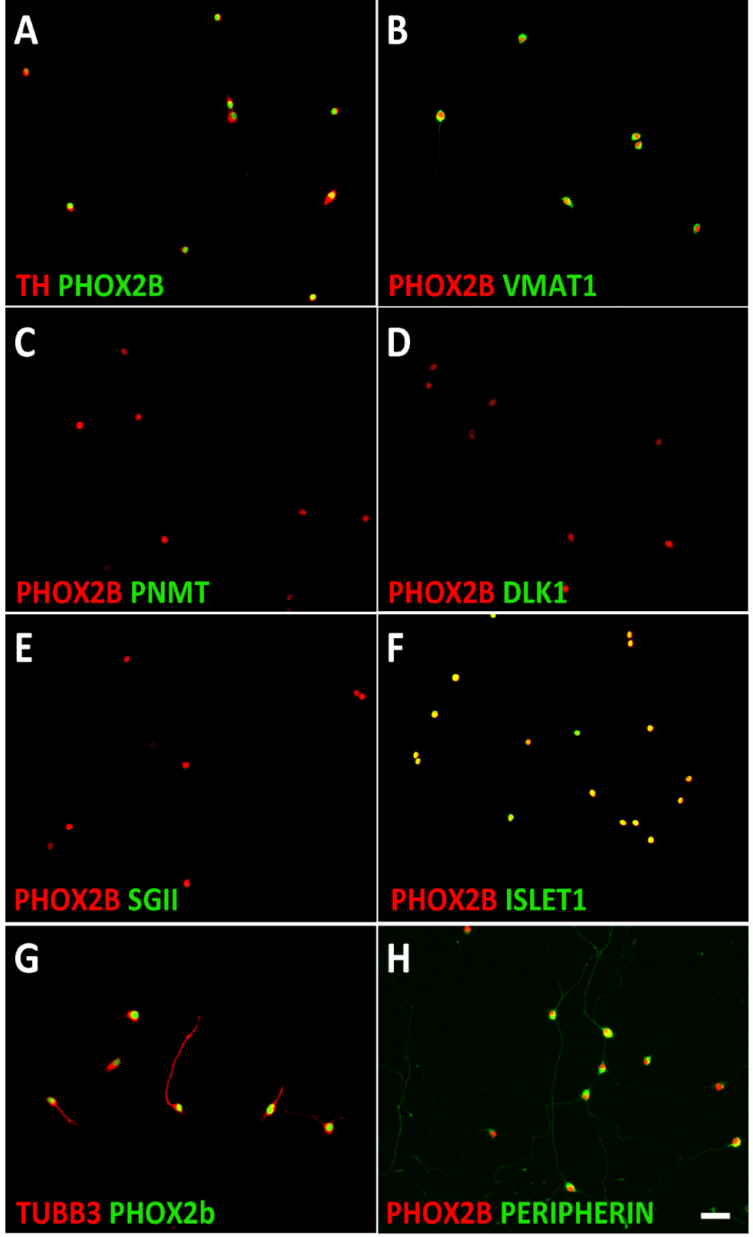
Figure 1. Characterization of mouse sympathetic neuroblasts. Dissociated E14.5 sympathetic ganglion cells were plated on porn/laminin-coated dishes in serum-free culture medium and analyzed after cell attachment. Double-immunostaining showed that all PHOX2B-positive cells co-express the noradrenergic markers TH ( A ) and VMAT1 ( B ) but not the chromaffin cell-specific proteins PNMT ( C ), DLK1 ( D ), and SGII ( E ). ISLET1 ( F ), TUBB3 ( G ), and PERIPHERIN ( H ) expression are shown as examples of neuron-specific proteins. Magnification bar, 60 µ